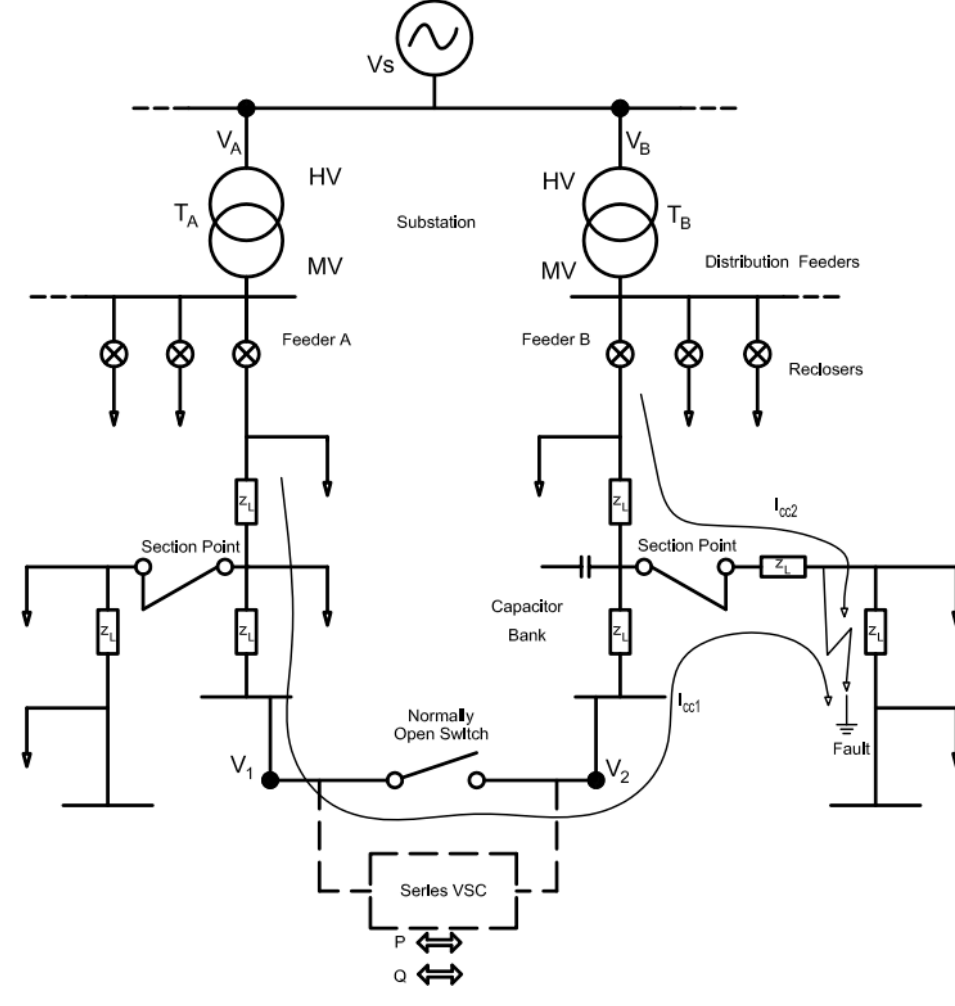
Figure 2. Typical distribution system .